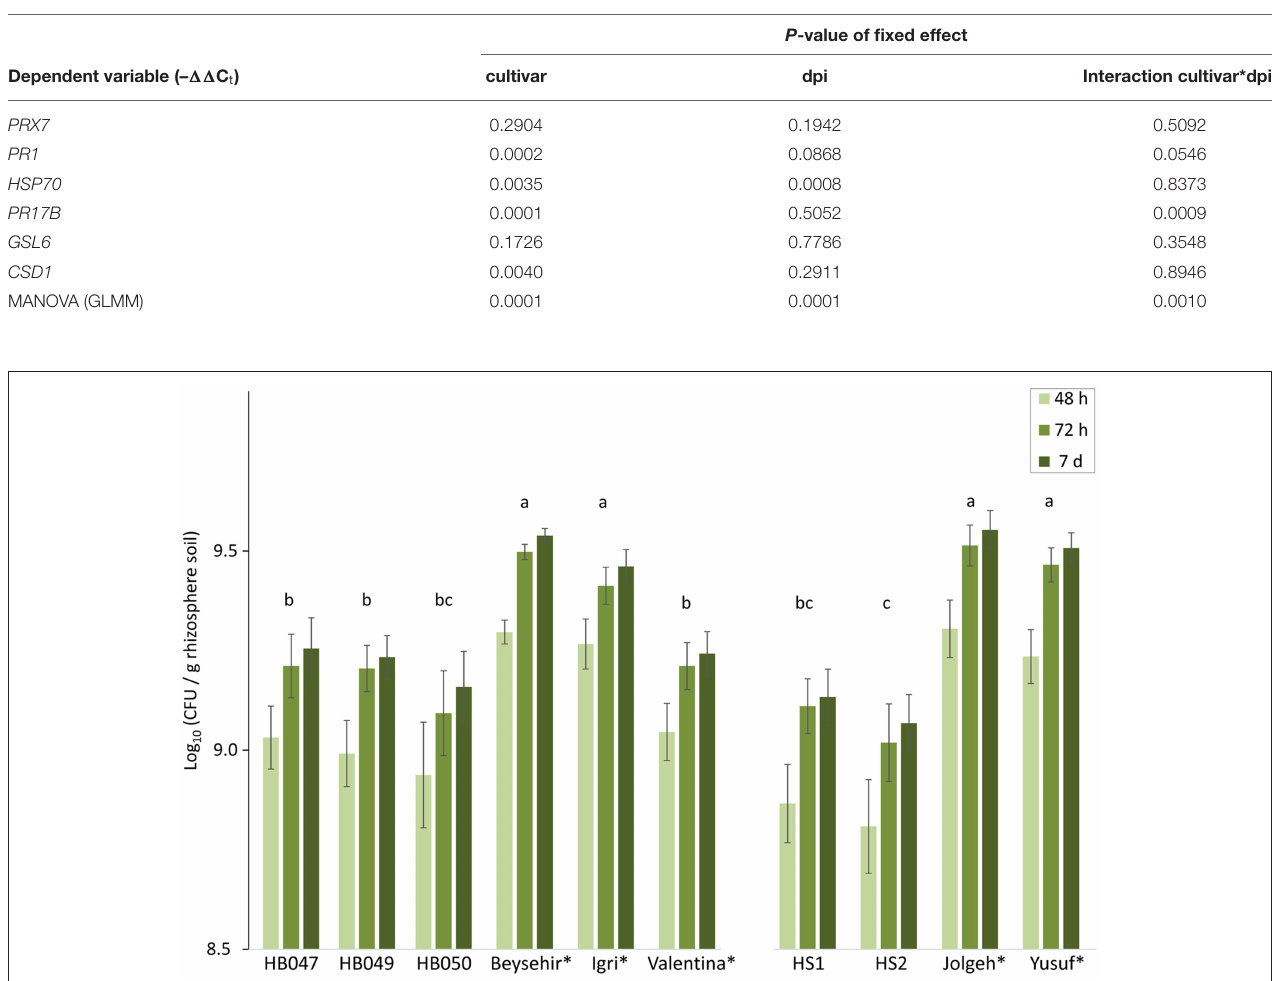
TABLE 2 | Generalized linear mixed models of microbiome-dependent defense gene expression of the barley cultivars Beysehir and Valentina, 1 and 3 days postinoculation (dpi) of root-lesion nematodes.